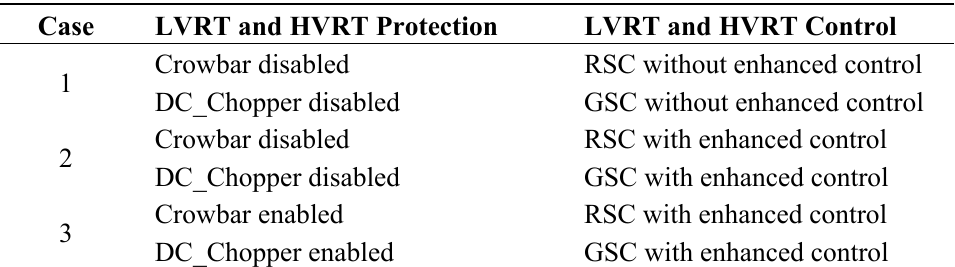
Table 1. Control schemes for case